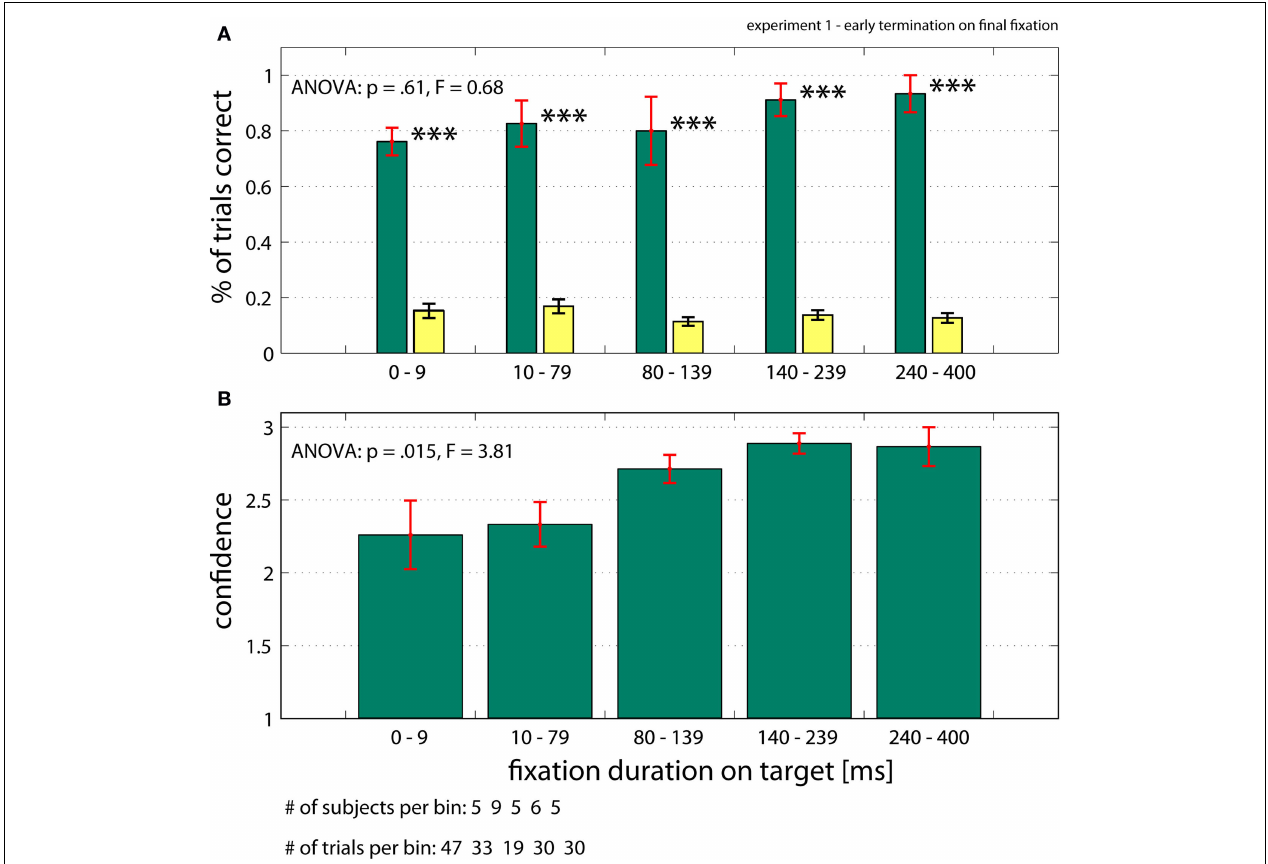
FIGURE 4 | Performance when trials were terminated after subjects fi xated on the target (early termination on fi nal fi xation, Experiment 1). (A) Subject’s performance (green bars) was independent of the time between fi xating the target and removal of the search screen. Note that for very short fi xation times of 1–10 ms, performance is highly signifi cantly different from